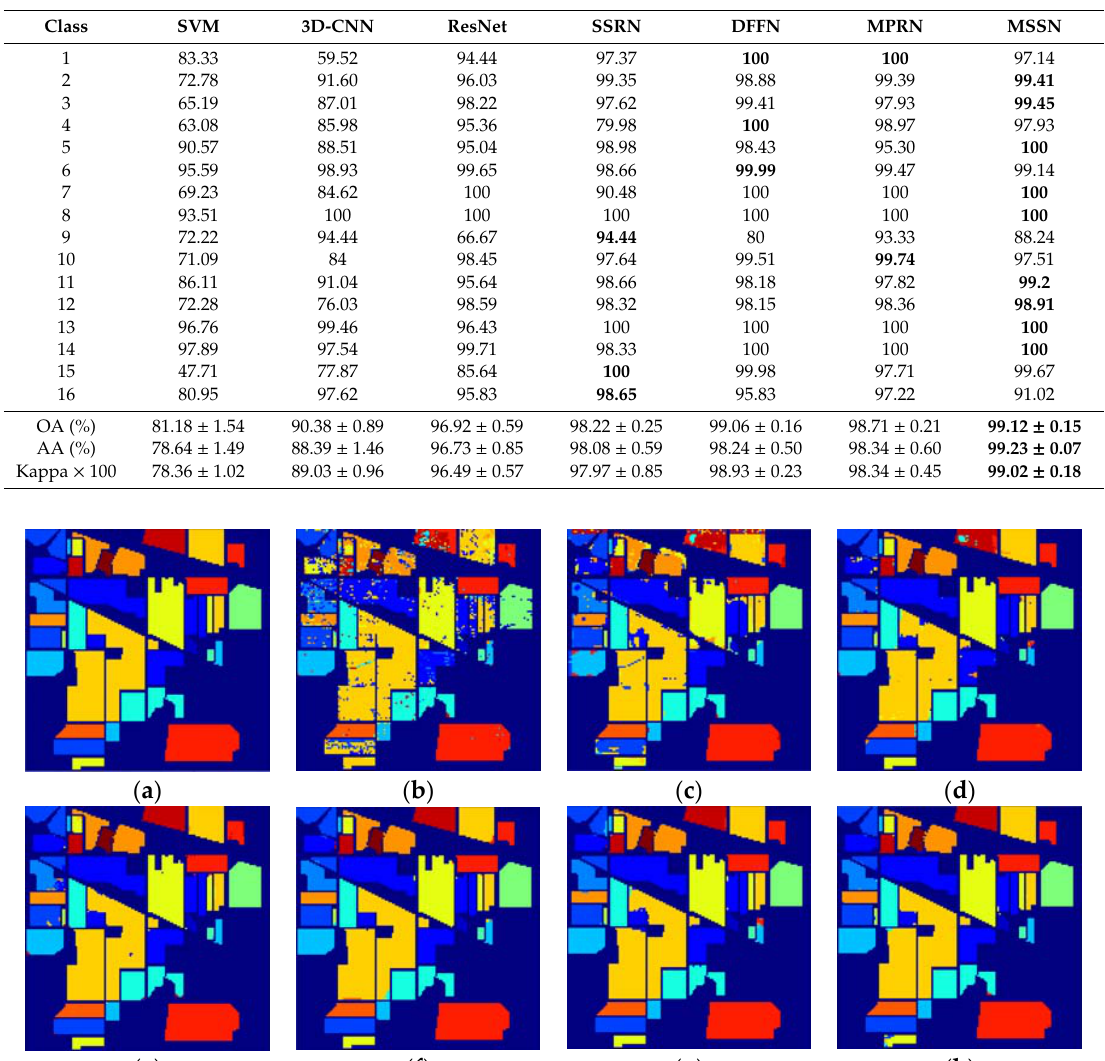
Table 4. Classification results obtained by di ff erent methods on the Indian Pines data set. Data are given as mean ± standard deviation. Legend: SVM, support vector machine; 3D-CNN, three-dimensional convolutional neural network; SSRN, spectral-spatial residual network; DFFN, deep feature fusion network; MPRN, multipath residual network.